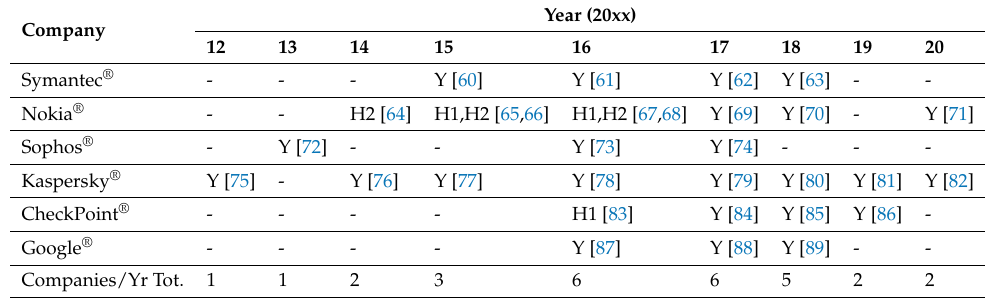
Table 1. Availability of informative reports that provide top families per AV service of the companies in the table. H1, H2: a report of the first and second half of the year, respectively; Y: company provides a full-year report. The last row represents how many vendors reported on that year, regardless of the number of reports/vendor